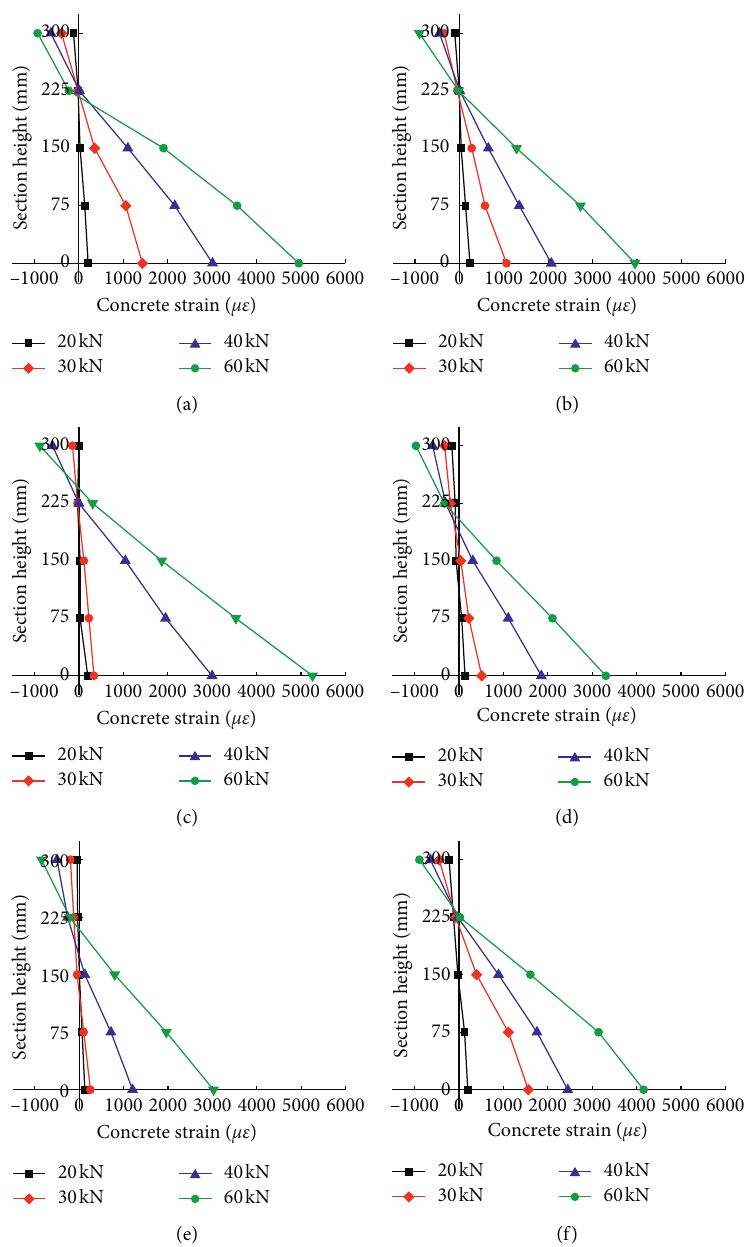
Figure 8: Concrete strain distribution along the height at the midspan section. (a) BKW1. (b) BKW2. (c) PKW1. (d) BKJ1. (e) BKJ2. (f)